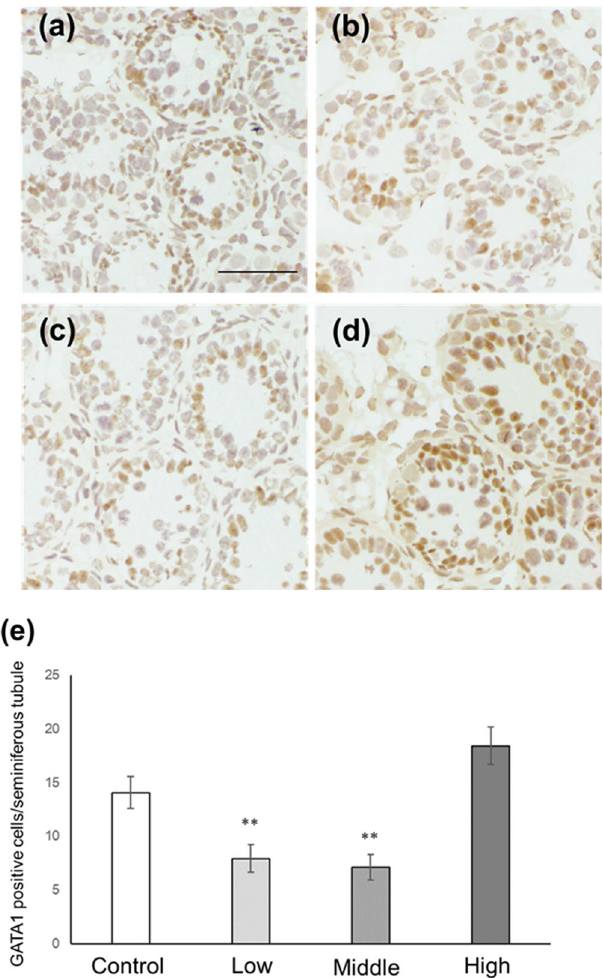
Figure 5. Number of GATA-1-positive Sertoli cells in CORT-administered mice on PND 10. Representative micrographs of Sertoli cells immunostained with anti-GATA-1 antibody in the testes from control ( a ), low- dosed ( b ), middle-dosed ( c ), and high-dosed-CORT mice ( d ) on PND 10. The scale bar is 50 µm. GATA- 1-positive cells per seminiferous tubule among the control and CORT mice ( e ). Values are expressed as the mean ± S.E.M of data from 10 animals per group (10 seminiferous tubules per animal). **p < 0.01 compared to the